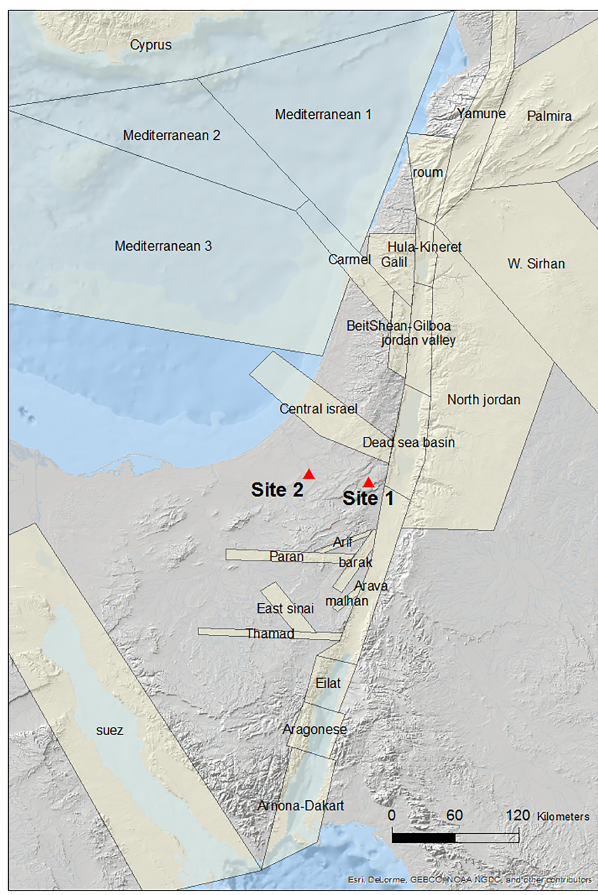
Figure 1. The seismotectonic model underlying the SI413 map (Klar et al., 2011). All seismic sources are represented as areal source zones. The boundary coordinates and seismicity parameters associated with this model are available in the